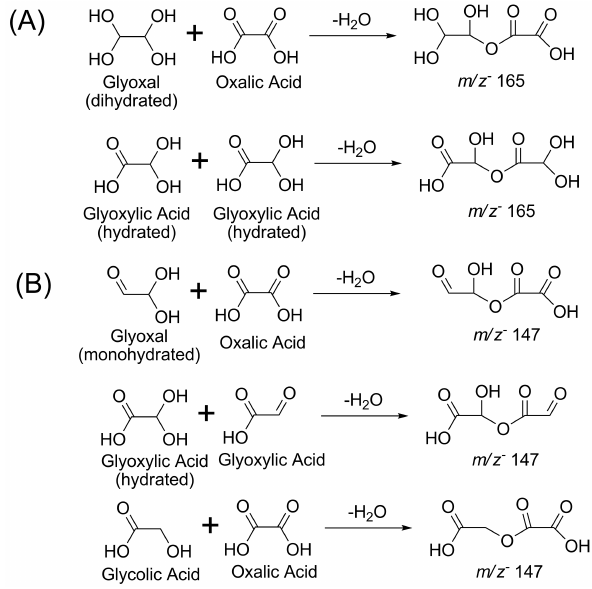
Fig. 7. Proposed acid-catalyzed esterification explaining m/z − 165 and 147 dimers found in the standard mixture.